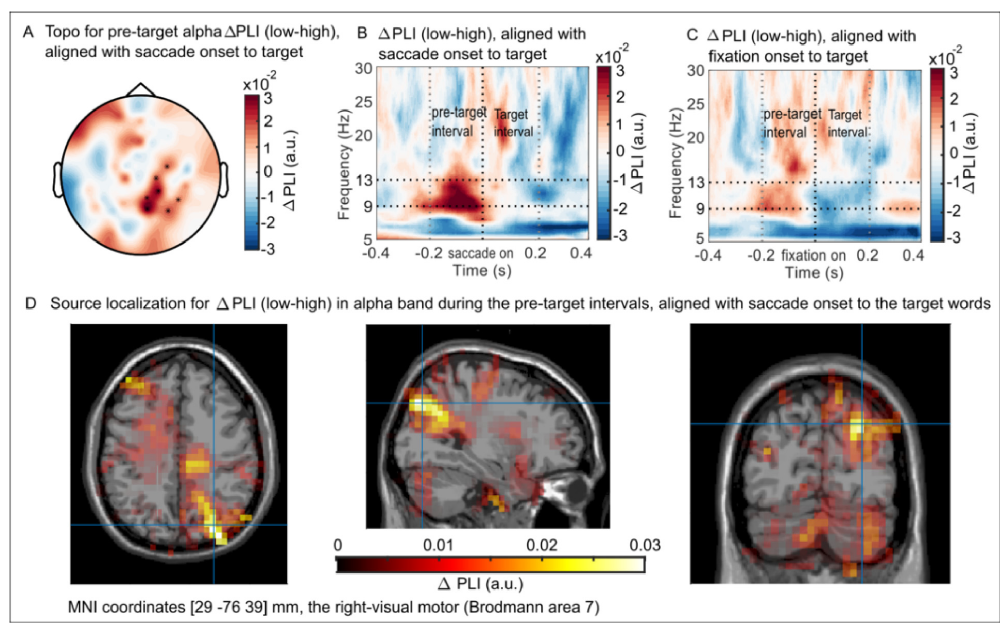
Fig 3. PLI for the pre-target interval aligned with saccade onset to target words. AU : AnabbreviationlisthasbeencompiledforthoseusedinFig 3 : Pleaseverifythatallentriesarecorrect : (A) Topography of the sensor clusters that showed a significant PLI difference in alpha band (9 to 13 Hz). The pre-target interval was aligned with the saccade onset towards target words (N = 38, P cluster = 0.006, cluster-based permutation test). (B) The averaged PLI difference (PLI low − PLI high ) over the significant sensor clusters in Fig 3A. (C) Using the same sensors as in Fig 3B but aligned with fixation onset towards the target, no robust effects were observed for the PLI difference during the pre-target interval. (D) Source localization of the alpha PLI difference during the pre-target interval in Fig 3B. The generator was localised to the right-visual motor cortex (Brodmann area 7) using an LCMV beamformer. The data in panel (B) and (C) in the figure can be found in S1 Data. LCMV, linearly constrained minimum variance; PLI, phase locking